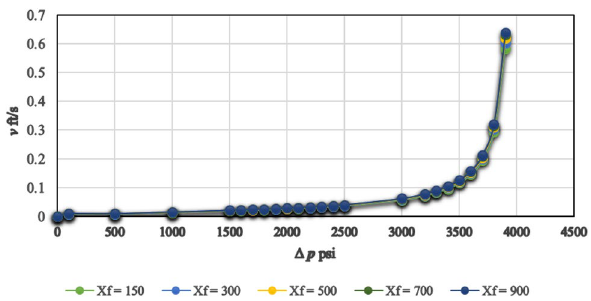
Fig. 6 Threshold velocity: flow velocity versus. pressure drop; x correlating parameter